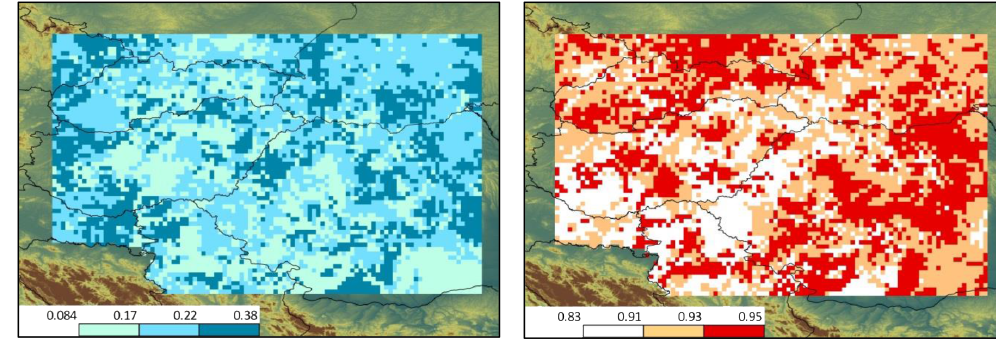
Figure A2. Duration factors p (left) and q (right) for dry cases in the Carpathian region (1961–2010).